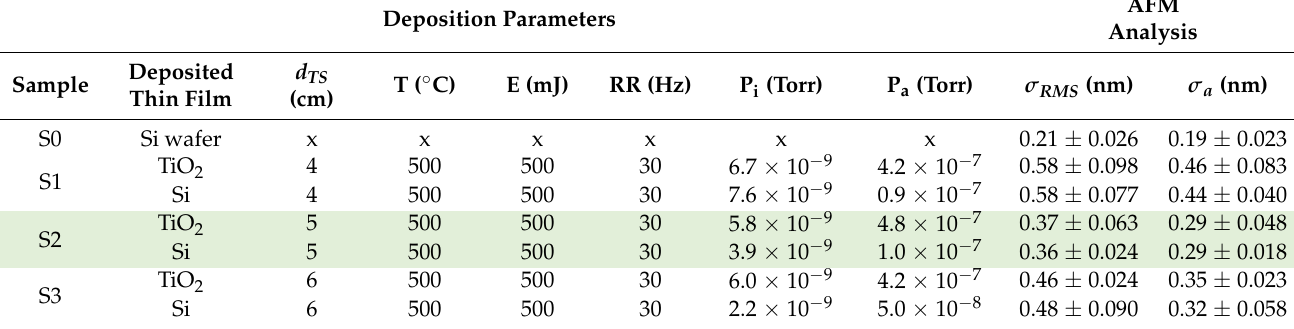
Table 1. The deposition parameters as: substrate temperature, laser power and pulse frequency, pressure before and during films deposition, and the corresponding σ RMS and σ a roughness calculated for the 2D topography images recorded for TiO 2 and Si thin films (5 × 5 µ m 2